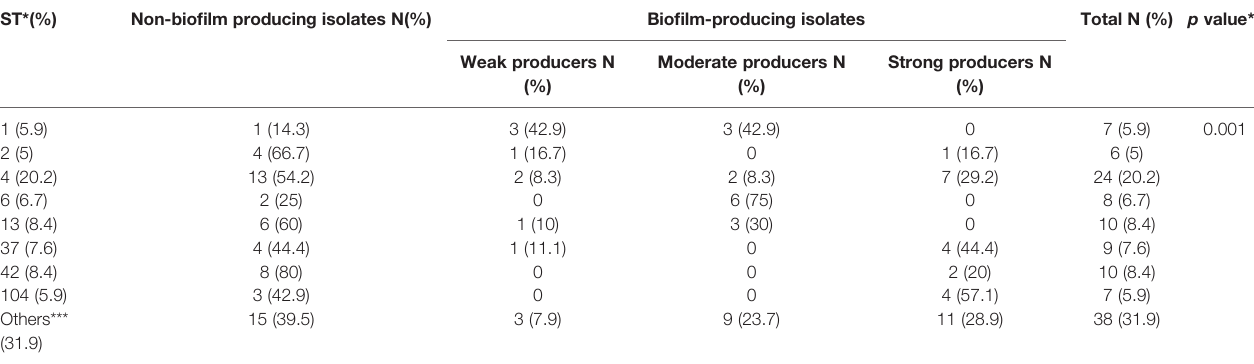
TABLE 3 | Bio fi lm production capacity among the different STs. ST*(%)